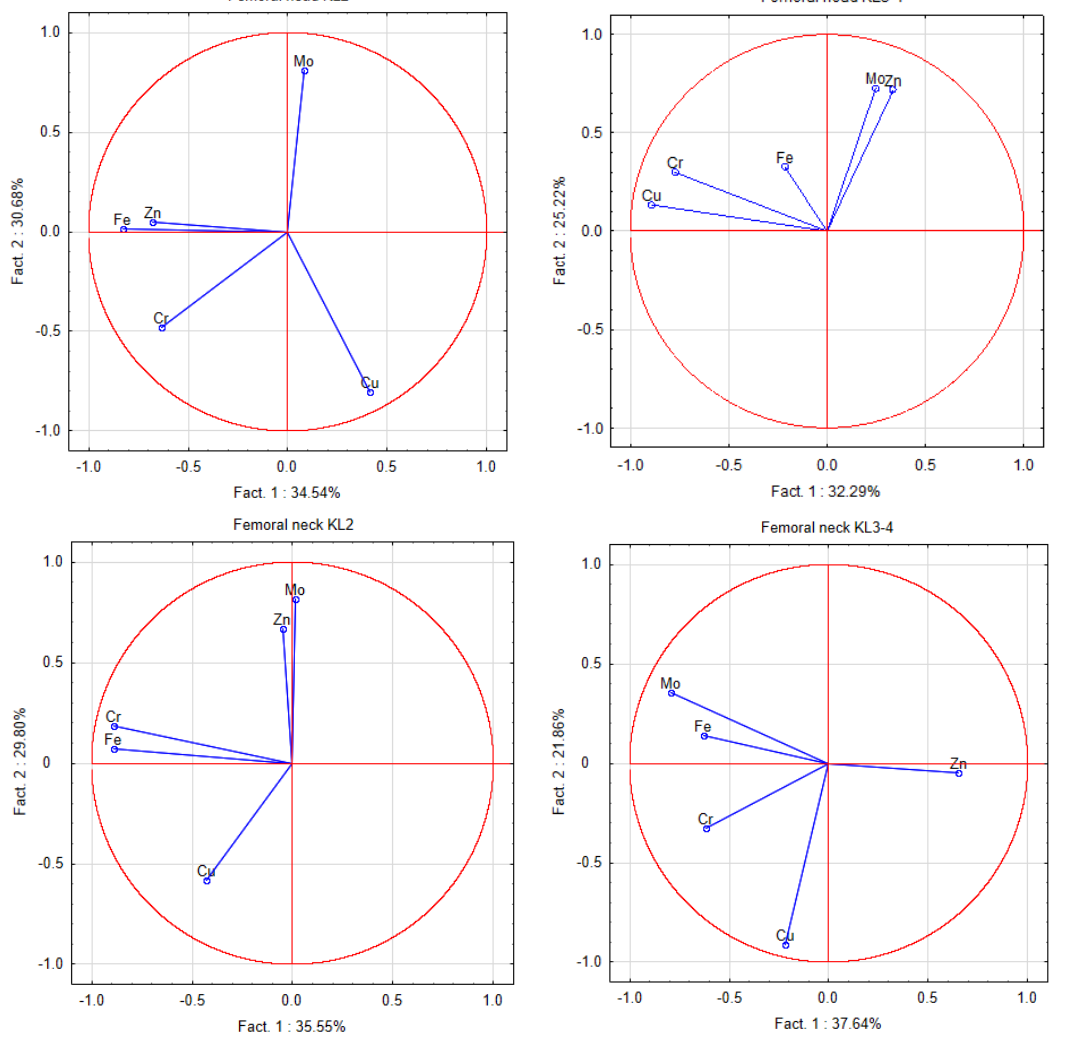
Figure 1. A graphic illustration of principal components analysis of the contents of elements in the femoral head and neck according to the Kellgren–Lawrence scale of hip OA. Projection of the variables on the factor plane of the first two principal components for the mild and severe grades of